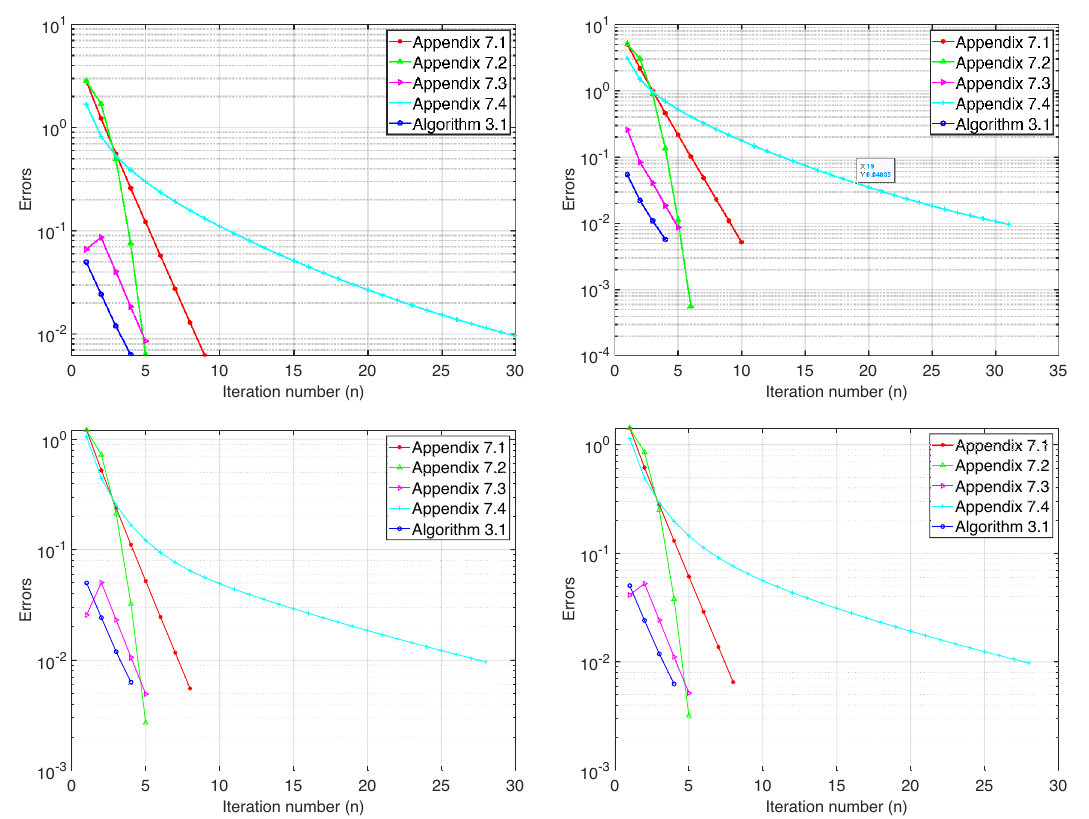
Figure 1: Top left: Case I; top right: Case II; bottom left: Case III; bottom right: Case